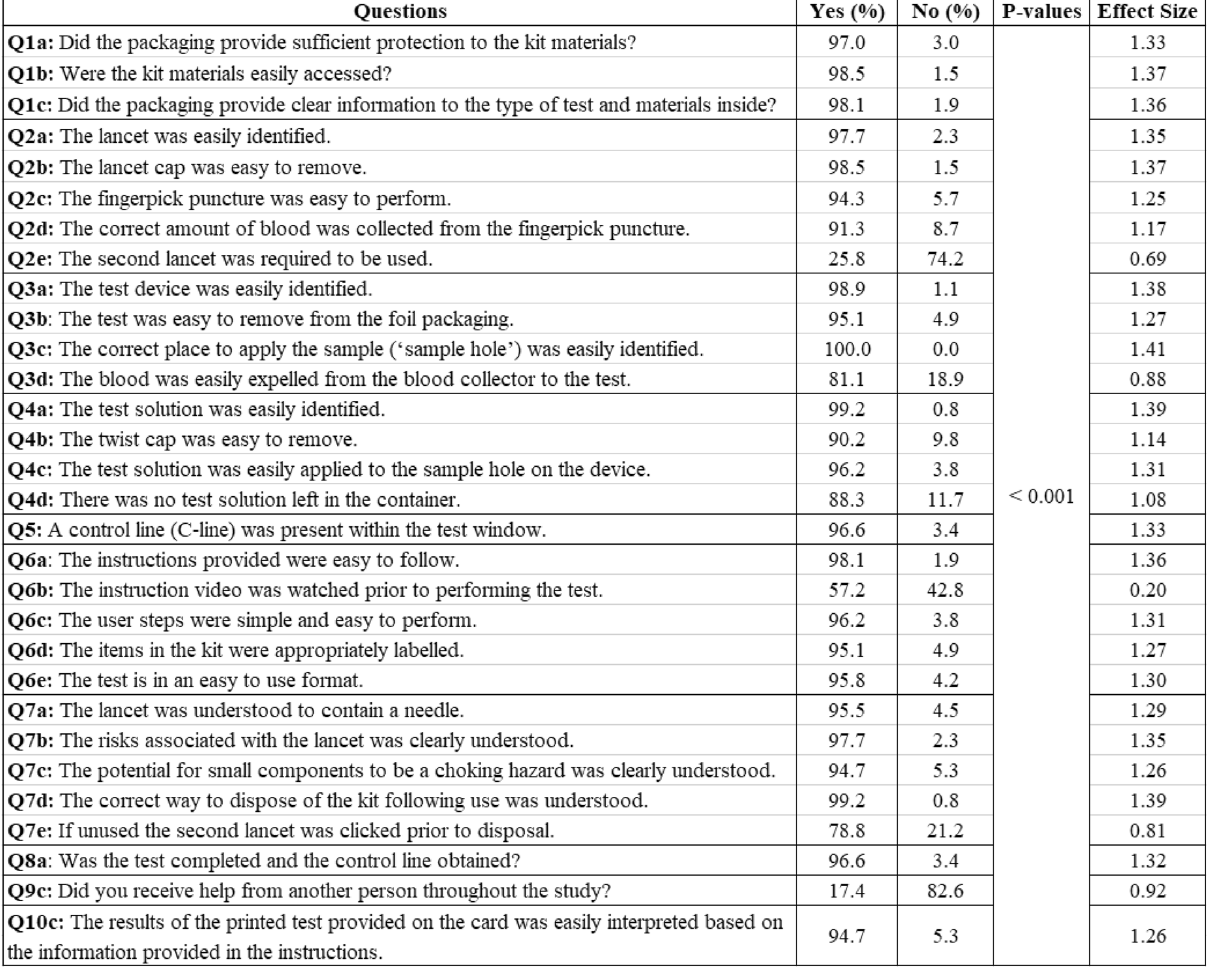
Figure 5. Summary of participants’ responses to polar questions survey together with p-values and effect size φ